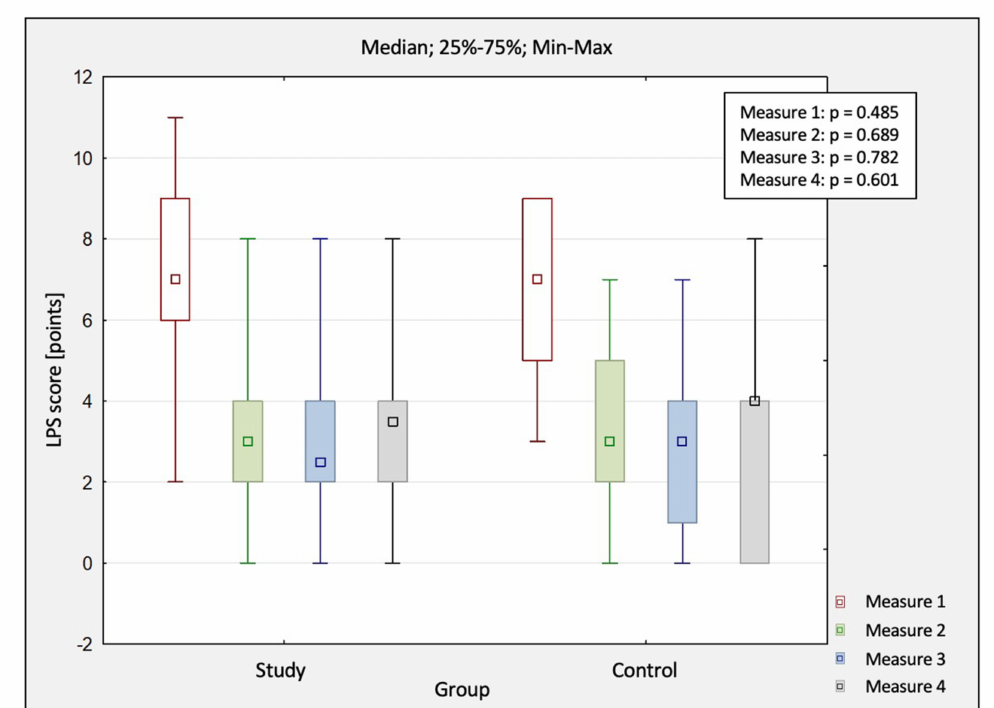
Figure 4. The comparison of changes in pain scores (LPS) between the study and control group. Abbreviations: M1, before treatment; LPS, Laitinen Pain Scale; M2, after treatment; M3, 1 month after study completion; M4, 3 months after study